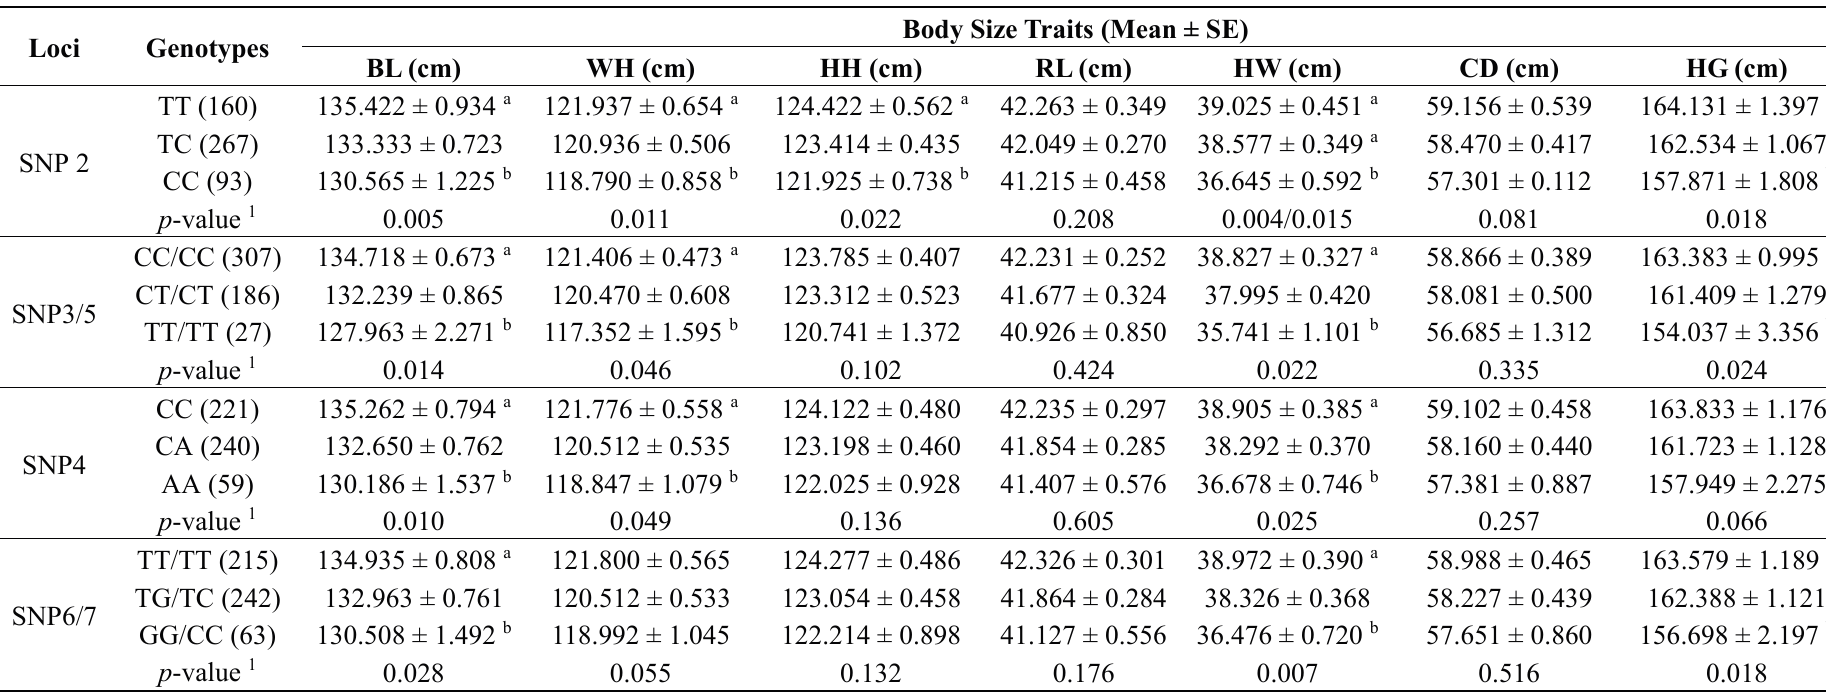
Table 4. Associations between different genotypes of SNPs detected in SMO and body size traits in Qinchuan cattle.